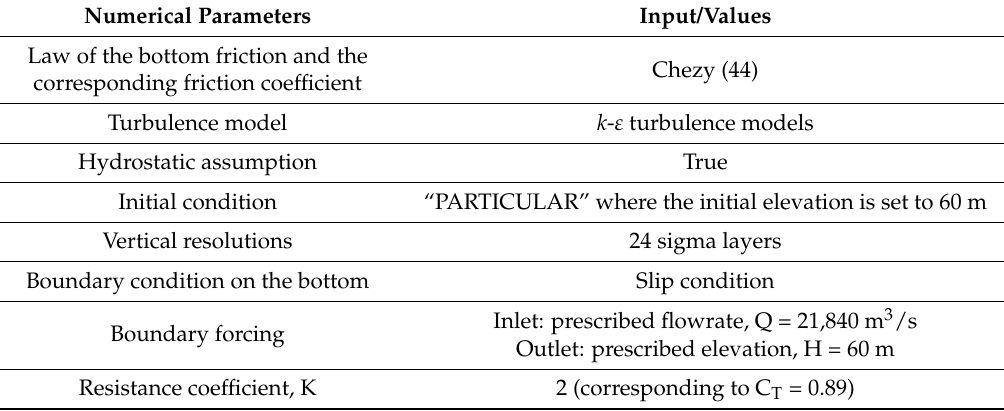
Table 2. Default values of the numerical parameters employed in the simulation of the actuator